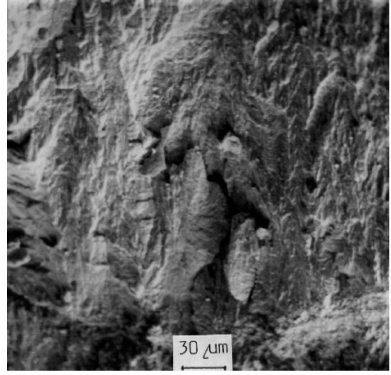
Figure 15. Fracture surface of cladding E 518 B.